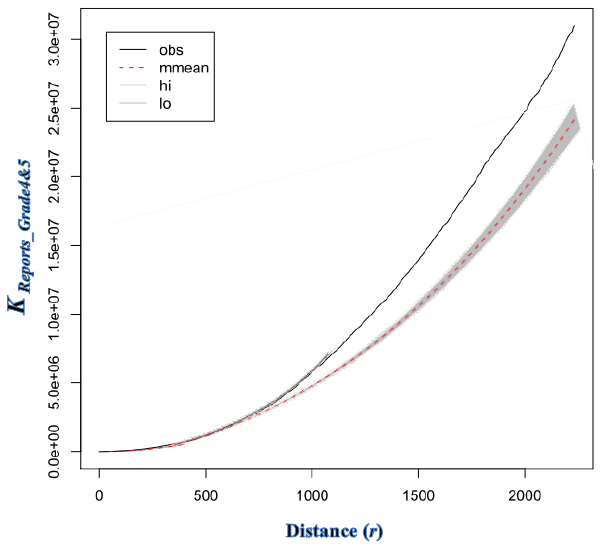
Figure 8. Simulated envelope for the fitted multi-type Strauss model for 99 realizations. Obs= observed values of the cross-K function; mmean= estimated theoretical value of the summary function, computed by averaging simulated values; hi= upper envelope of simulations; lo= lower envelope of simulations.